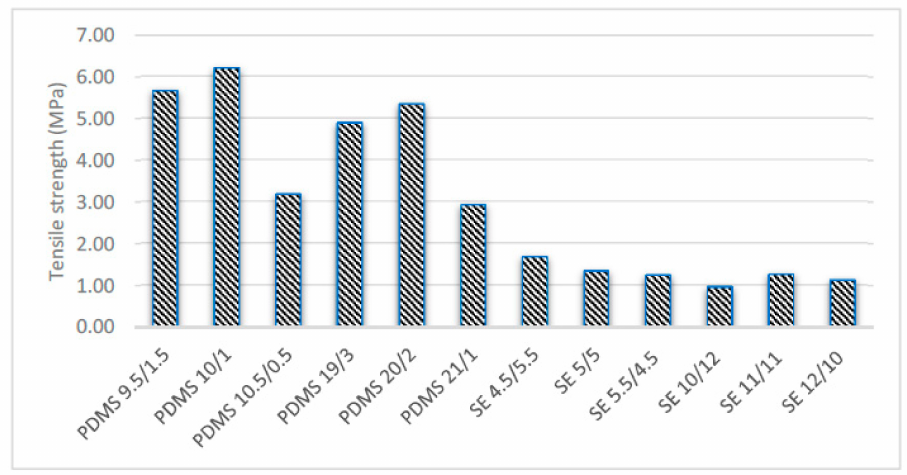
Figure 6. Tensile strength for various mixtures and thicknesses.